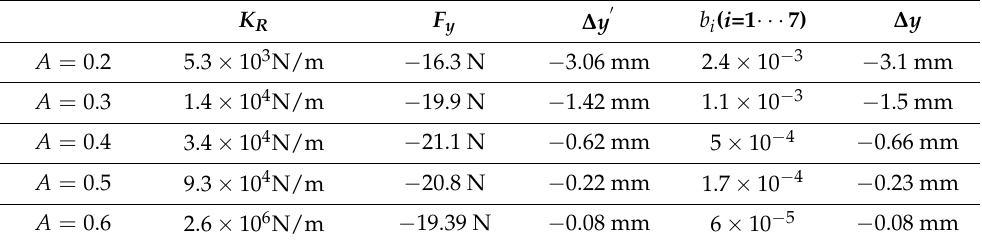
Table 2. Generalized displacements of the end effector under different parameters.